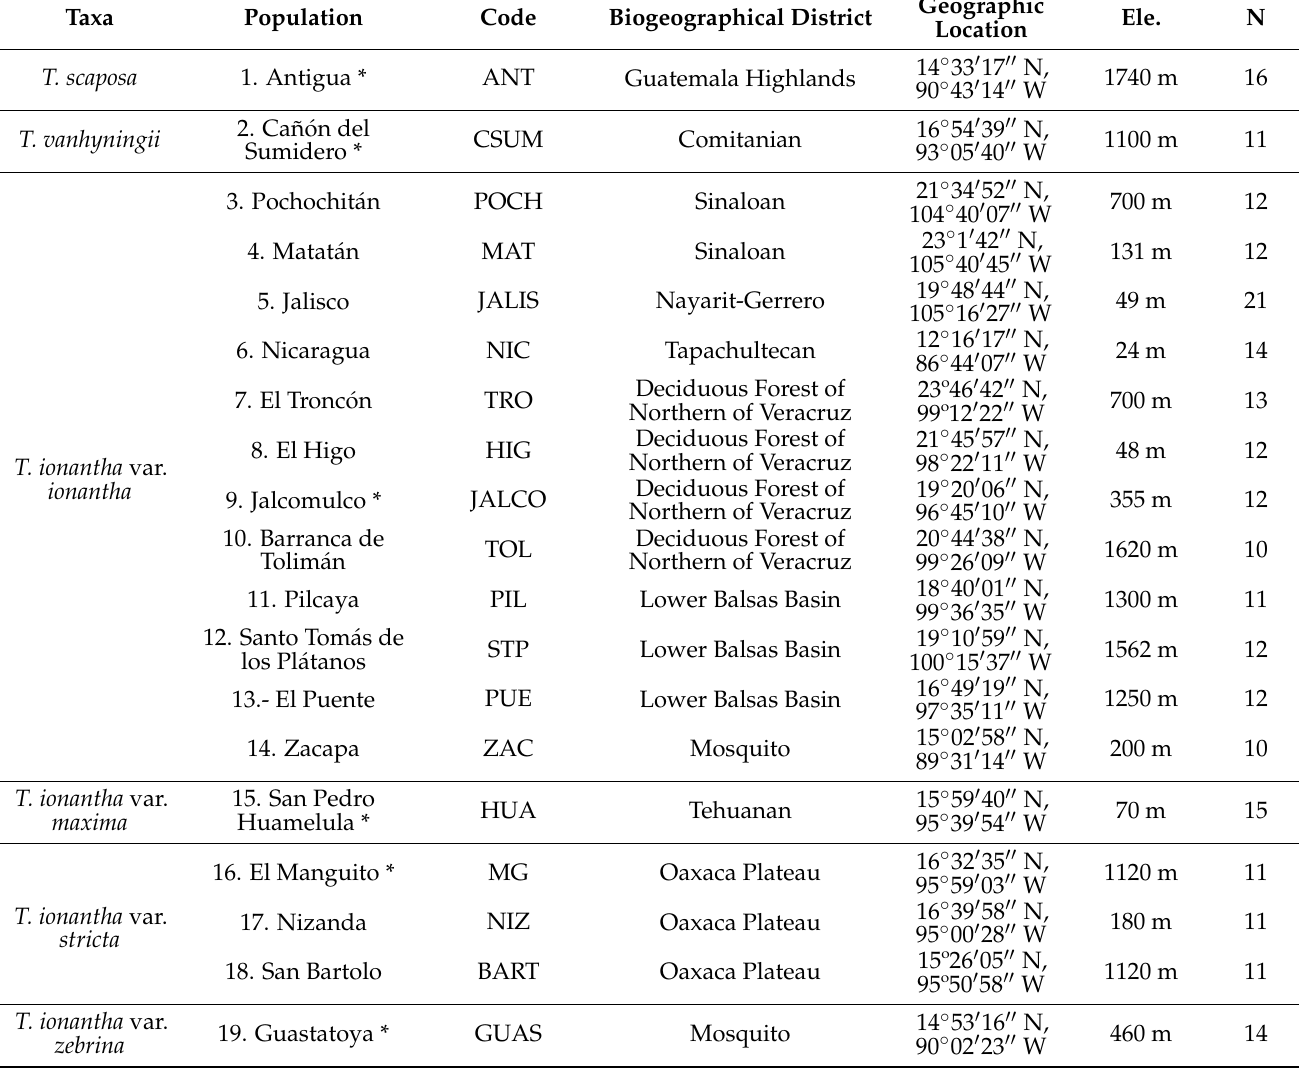
Table S4 specifies the names and sequences of the primers used in the amplification and the PCR conditions. The rps16-trnQ , rpl16 - rps3 and trnT-trnL-trnF markers were amplified in a single fragment and various internal primers were used for sequencing (Table S4). The Polymerase Chain Reaction (PCR) was performed in a final volume of 20 µ L. The mix consisted of 10 µ L of Phusion Hot Start II High-Fidelity PCR Master Mix (Thermo Fisher Scientific, Waltham, MA, USA); 1 µ L of each primer (forward and reverse) at a concentration PHYC molecular marker was amplified and sequenced into two overlapping fragments (Table S4). For PHYC the PCR was performed in a final volume of 10 µ L. The mix consisted of 5 µ L de GoTaq ® Green Master Mix (Promega Corporation, Madison, WI, USA); 1 µ L of each primer (forward and reverse) at a concentration of 10 µ M; 1 µ L of 0.04% BSA; 2.2 µ L ultrapure water; and 1 µ L de DNA (2–8 µ g/ µ L). The PCR products were purified and sequenced at Macrogen, South Korea. The sequences were assembled using Sequencher, aligned with ClustalW [58] implemented in MegaX [59] and manually edited in BioEdit [60]. Table 2. Taxa, populations, code and biogeographical districts of the individuals collected. * = type locality. Ele. = Elevation. Biogeographical districts sensu Morrone [28,29]. N = Individuals collected. Code